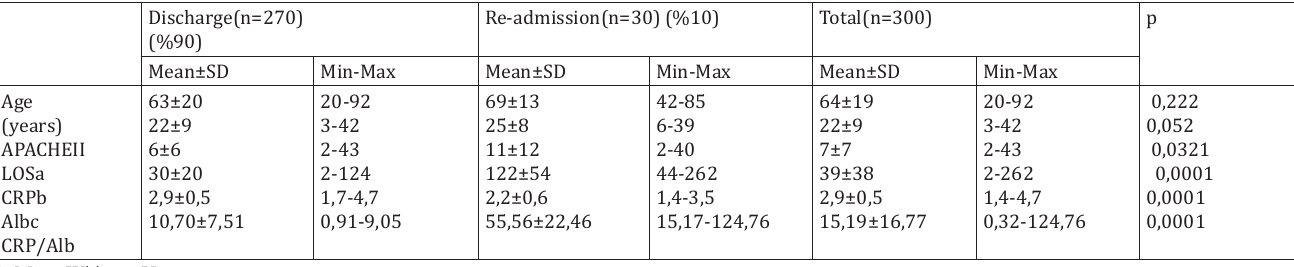
Comparison of re-admission and discharge groups